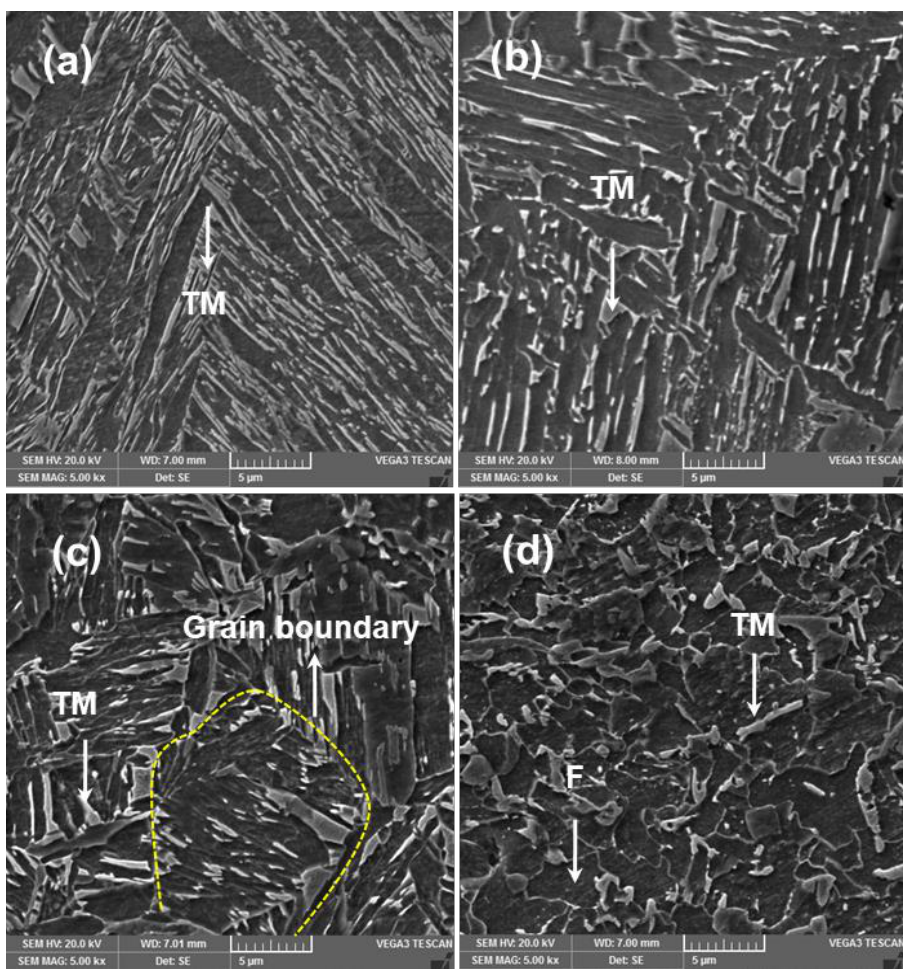
Figure 9. Microstructure evaluation of DPW16 RSW. ( a ) FZ, ( b ) CGHAZ, ( c ) FGHAZ and ( d ) SCHAZ.